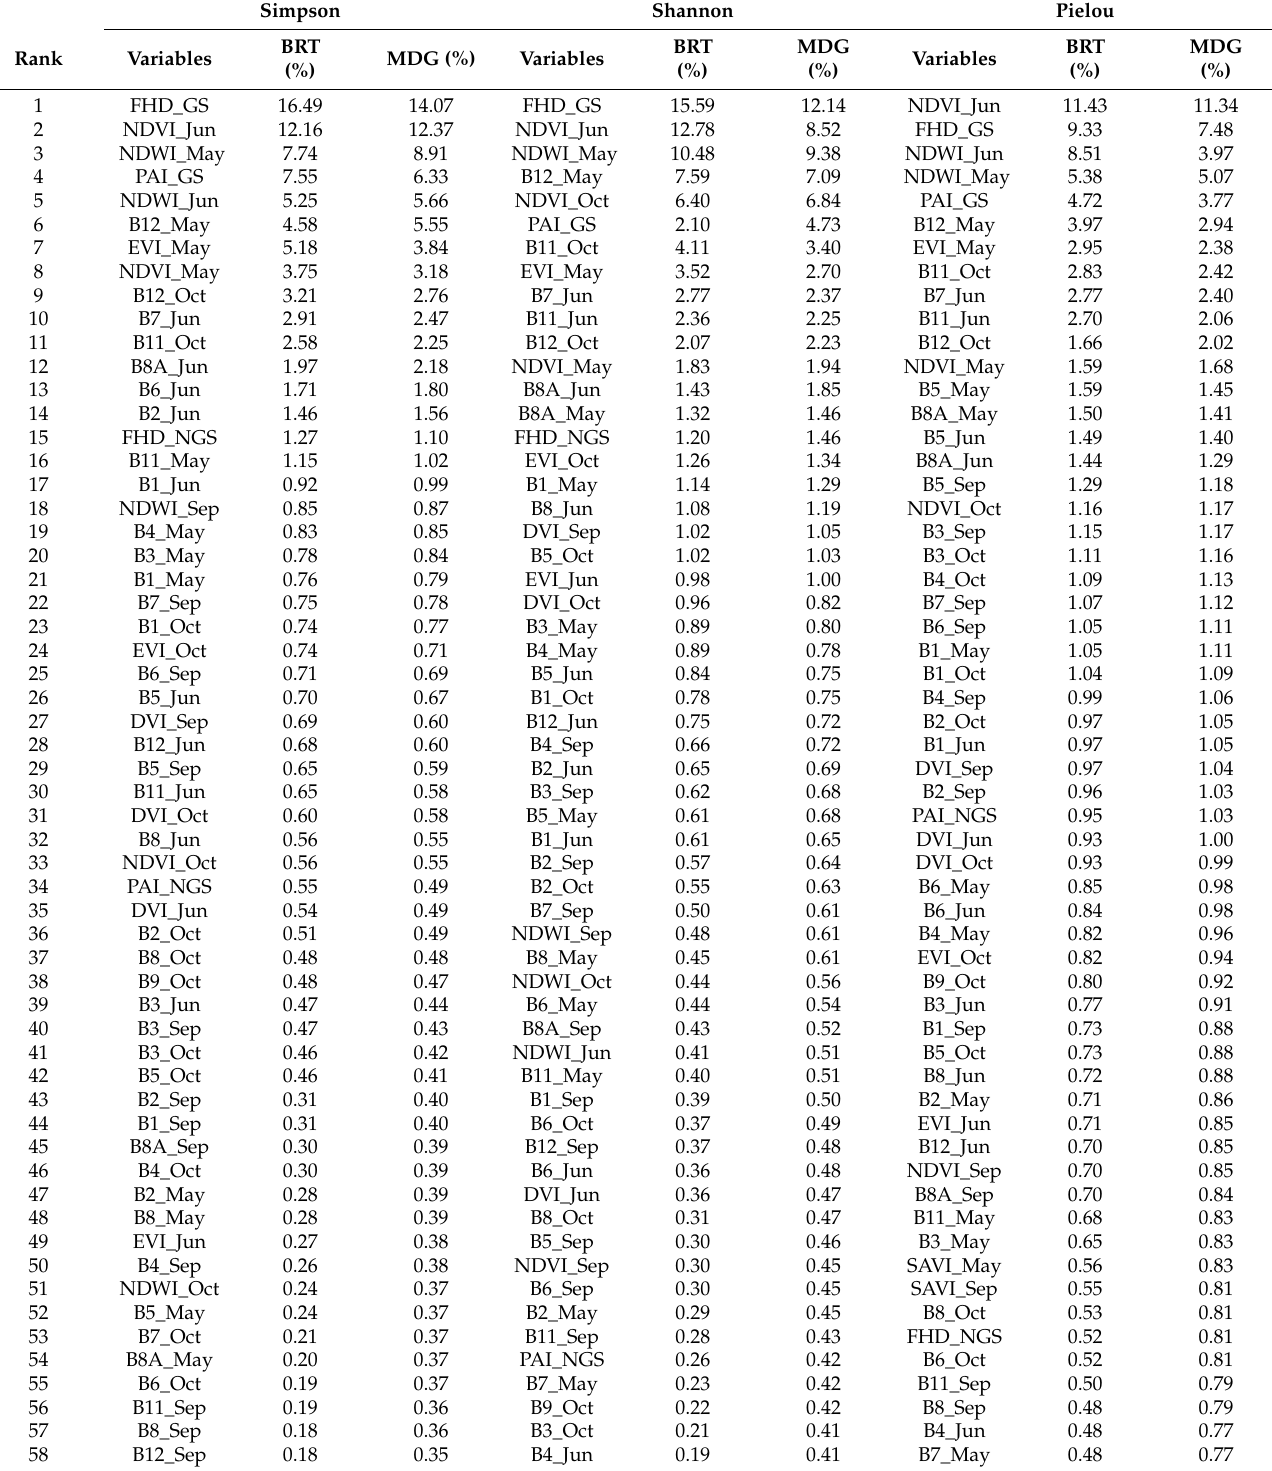
Table A1. Detailed results of variables